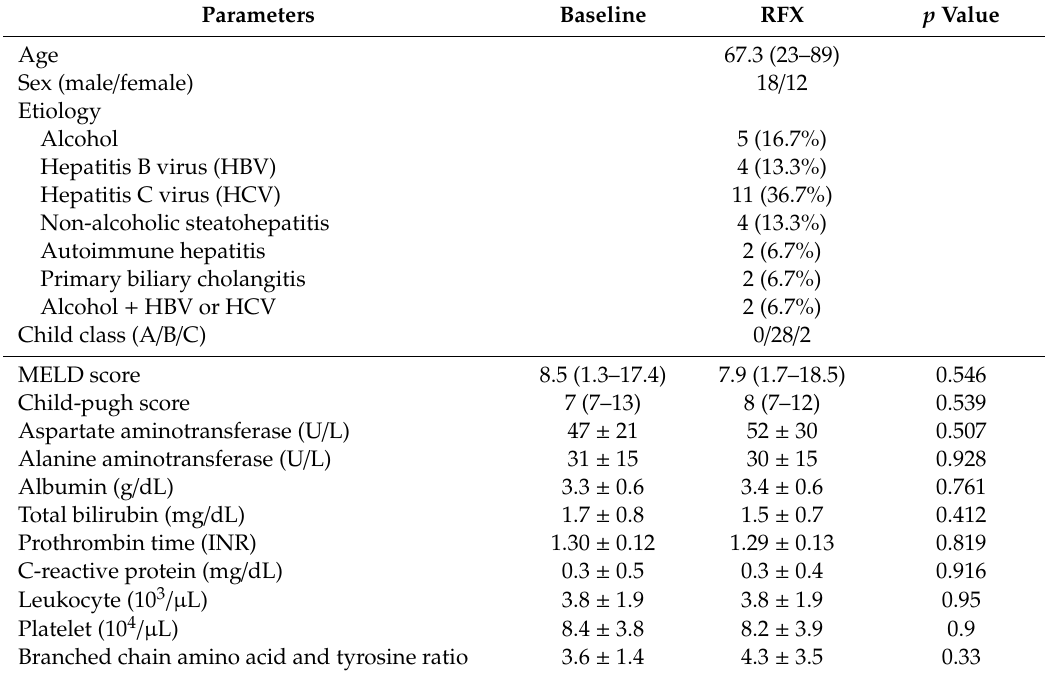
Table 1. Characteristic features of patients ( n = 30).